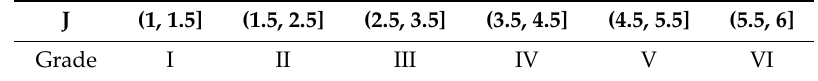
Table 4. Definition of eutrophication grade by non-integral eutrophication feature value